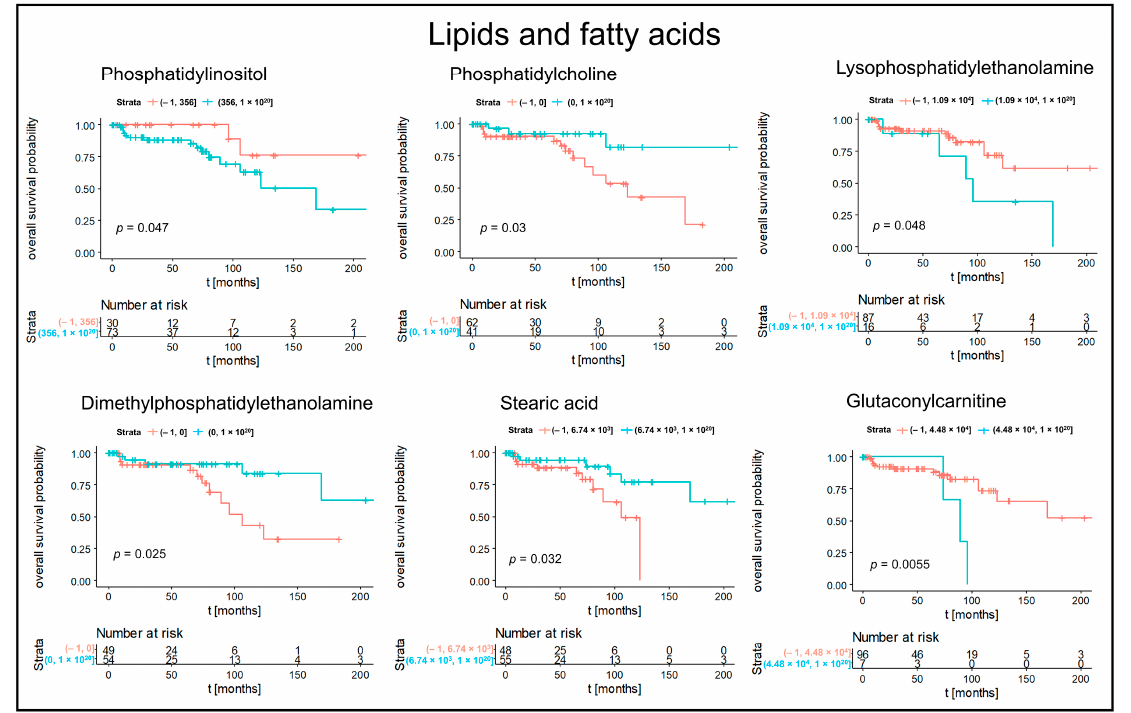
Figure 5. Kaplan–Meier significant metabolites specific for subtype chRCC. Blue lines indicate survival in patients with high intensity of the respective mass. Red lines indicate survival in patients with low intensity of the respective mass.